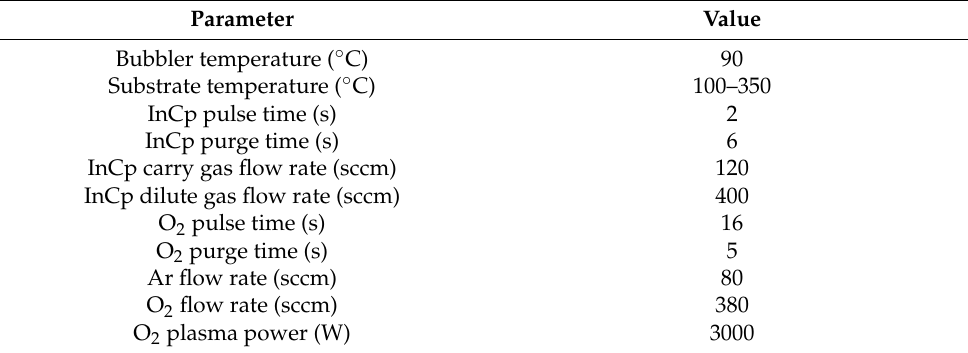
Figure 1 . The flow rates of gases in the atomic layer deposition (ALD) process with respect to the time sequence. Table 1. Deposition parameters of the plasma-enhanced ALD (PEALD) In 2 O 3 films.